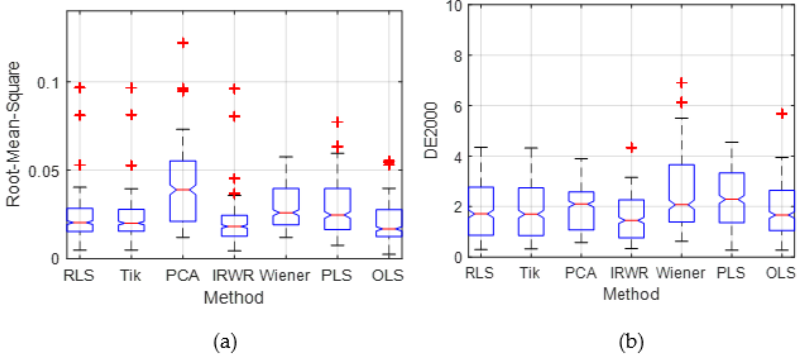
Figure 7. The relevant summary statistics of the proposed method and the existing methods, the outliers are plotted individually using the ‘ + ’ symbol. ( a ) Boxplot distributions of the RMS. ( b ) Boxplot distributions of the CIEDE2000 color difference.